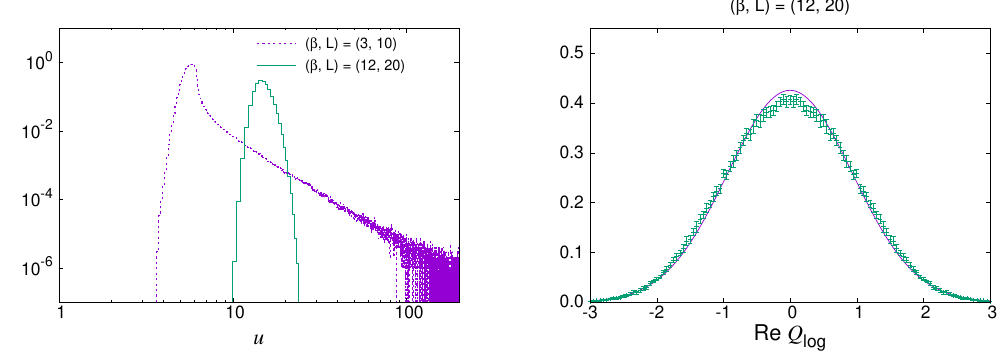
Figure 7 . The results obtained by the CLM for the punctured model using the log de(cid:12)nition Q log of the topological charge. (Left) The histogram of the magnitude u of the drift term de(cid:12)ned by (3.12) is shown for ( (cid:12); L ) = (3 ; 10) and (12 ; 20) with (cid:18) = (cid:25) . (Right) The histogram of Re Q log is shown for ( (cid:12); L ) = (12 ; 20) with (cid:18) = (cid:25) . The exact result obtained for ( (cid:12); L ) = (12 ; 20) with (cid:18) = 0 is shown by the solid line for